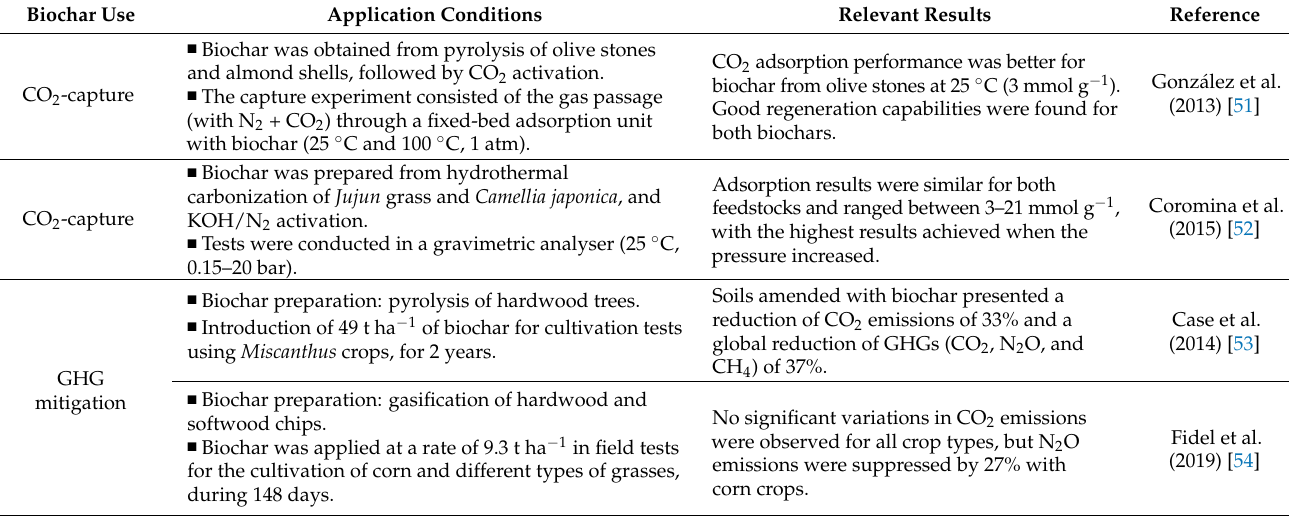
Table 4. Summary of studies about biochar applications for GHG emissions